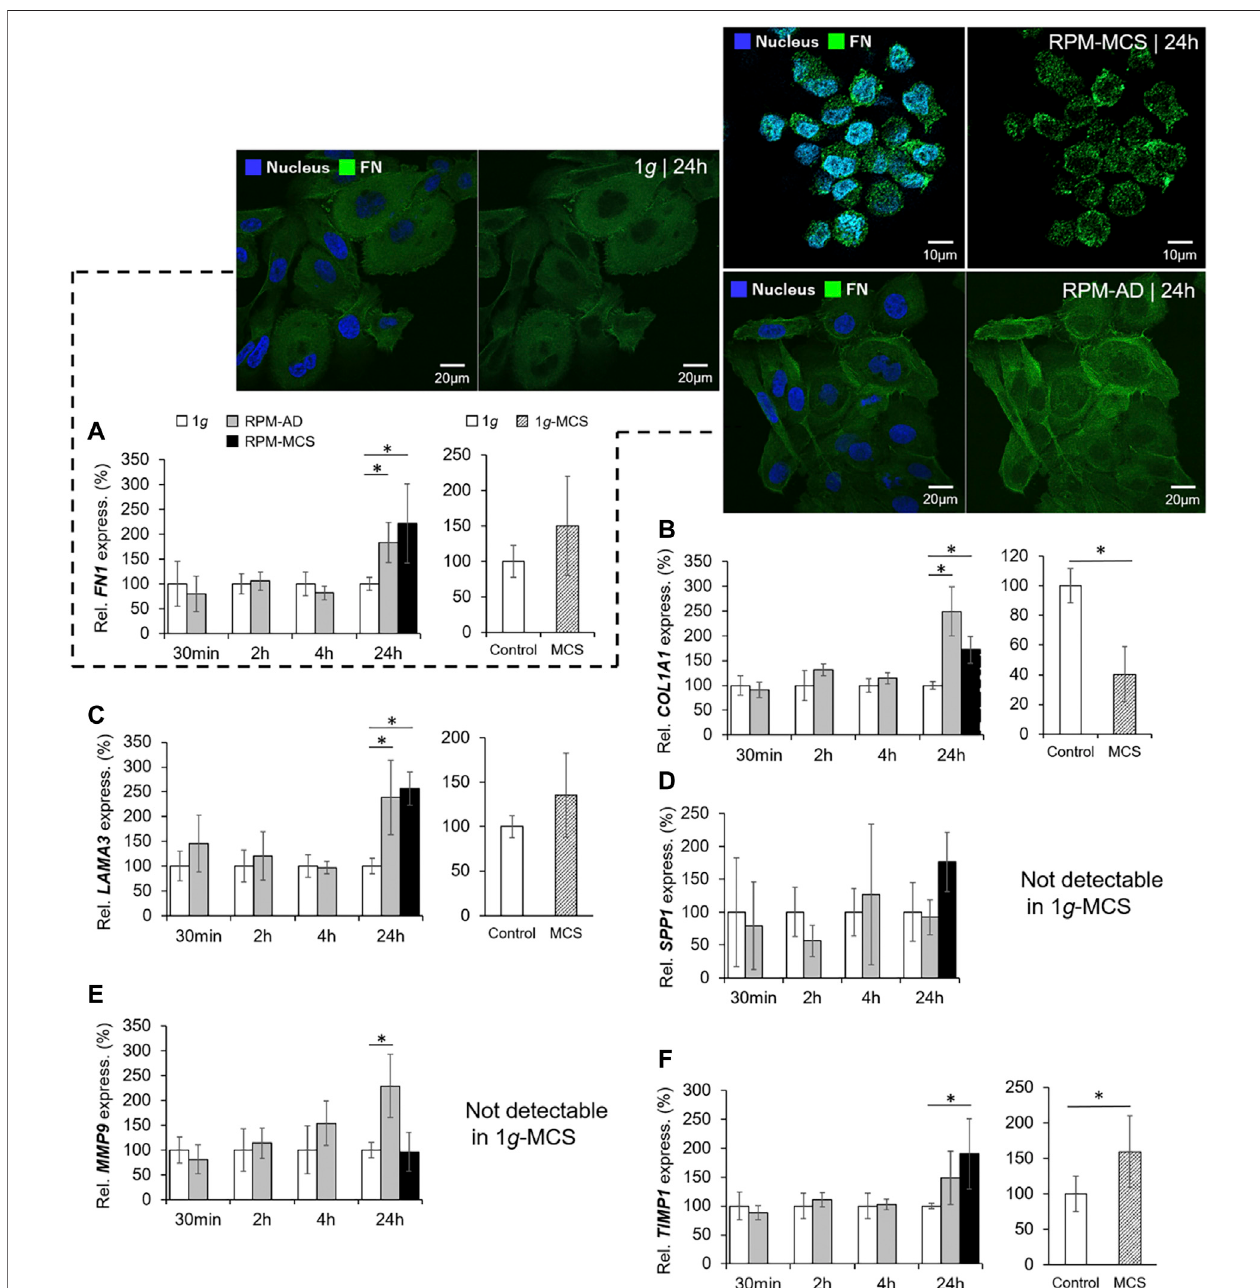
FIGURE4| Extracellularmatrix:Geneexpressionof (A) FN1 andimmuno fl uorescenceof fi bronectin:lefttwoimagesofthe1 g /24 hsample(mergedleftpictureand fi bronectin (Alexa Fluor 488) right picture), top right two images of the RPM/24 h MCS samples (merged left picture and fi bronectin right picture) and lower right two imagesoftheRPM/24 hADsamples(mergedleftpictureand fi bronectin rightpicture),DAPI-stainednucleus(blue), (B) COL1A1 , (C) LAMA3 , (D) SPP1 , (E) MMP9, and (F) TIMP1 of PC-3 cells exposed to the RPM for 30 min, 2, 4 and 24 h and 1 g -MCS after 24 h. n = 5; * p < 0.05 vs. 1 g .